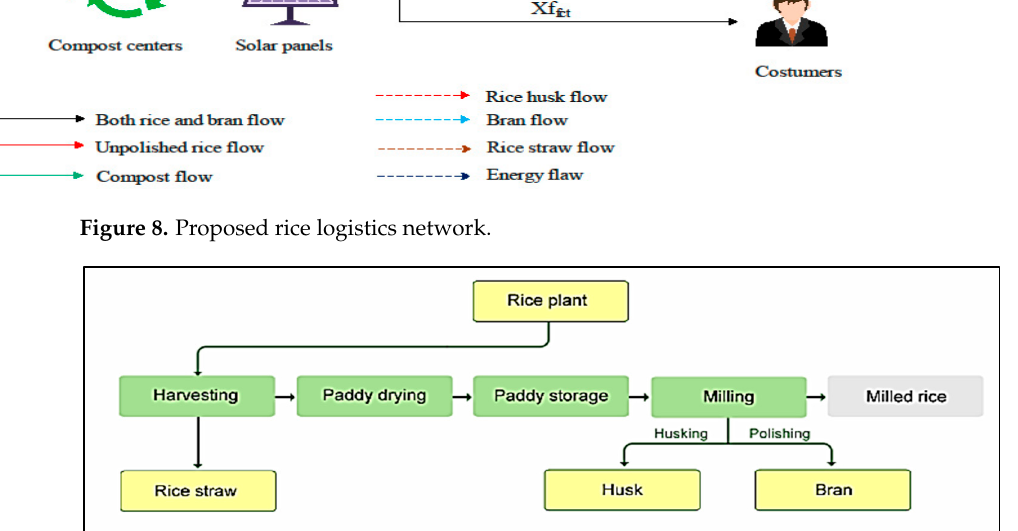
Figure 9. Rice production stages.